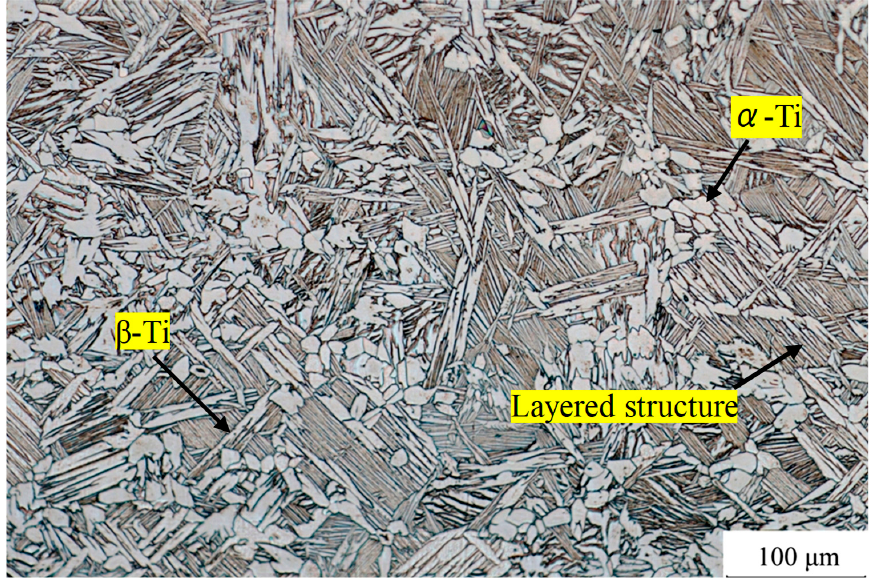
Figure 7. Metallographic microstructure of the Ti-6Al-4V base metal after vacuum brazing.